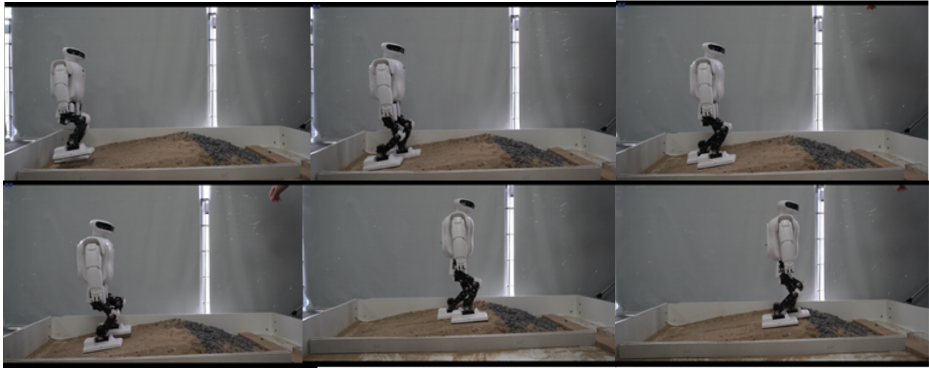
Figure 14. Walking on a sandy